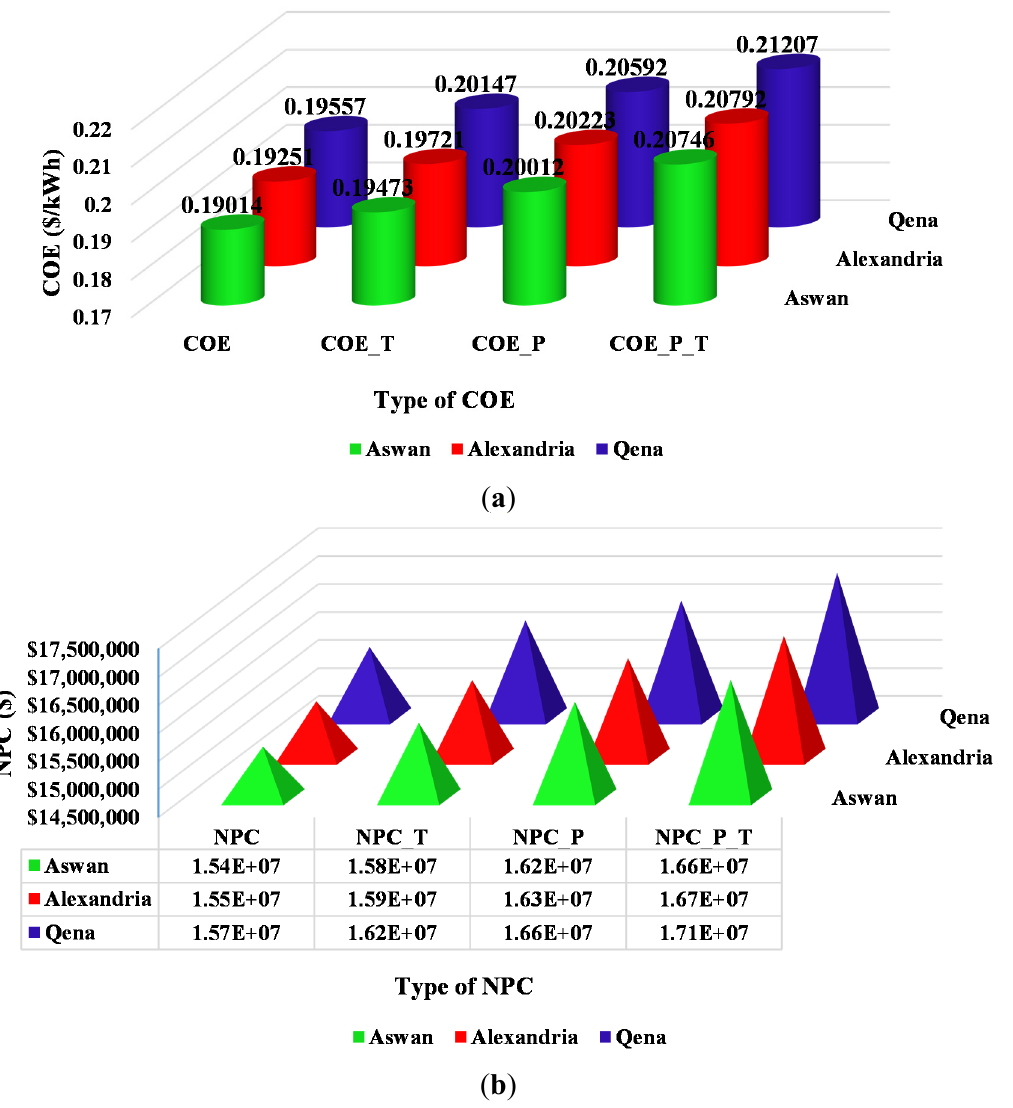
Figure 9. ( a ) The different COE of PV/diesel/battery system in Aswan, Alexandria and Qena; ( b ) The different NPC of PV/diesel/battery system in Aswan, Alexandria and